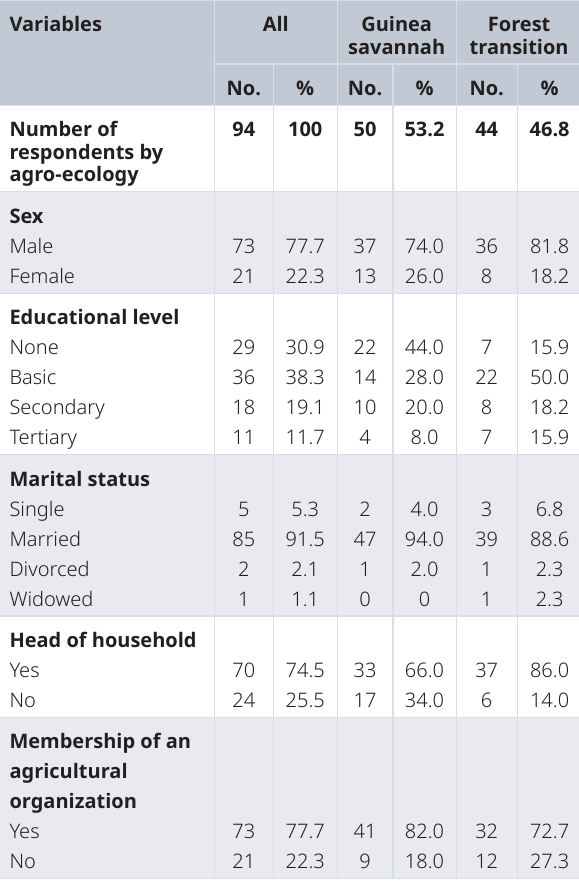
Table 1. Demographic characteristics (categorical